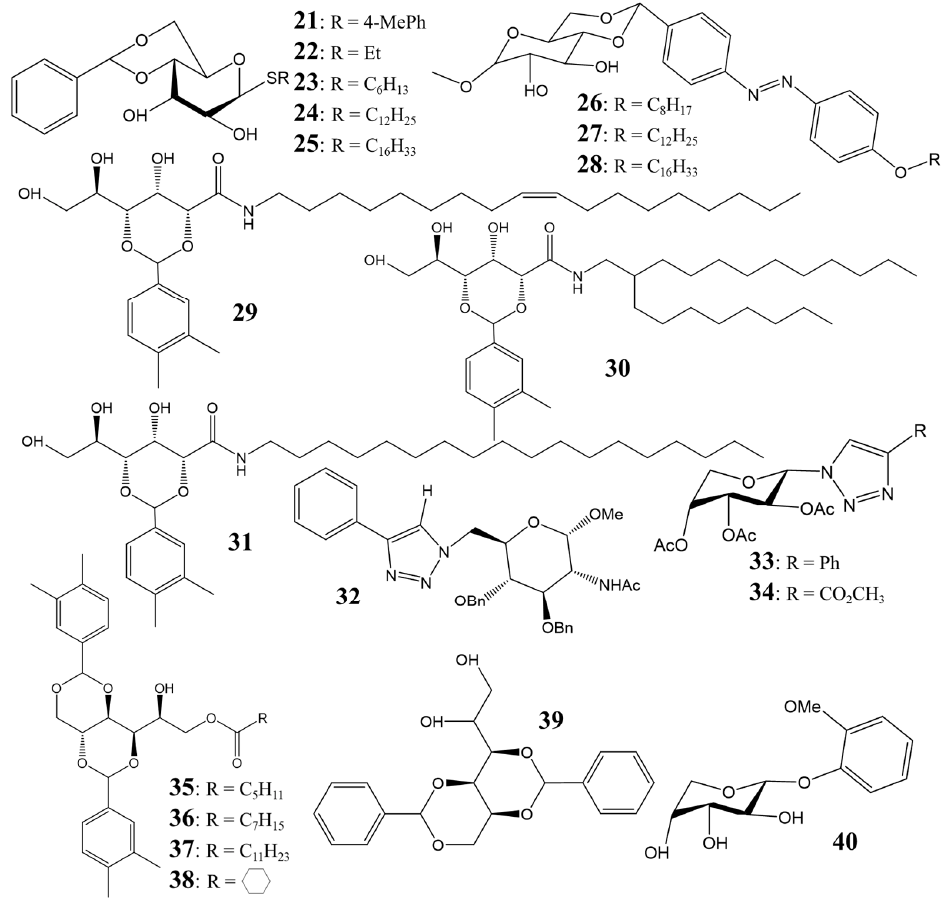
Figure 3. Chemical structures of PSOGs 21 – 40 .